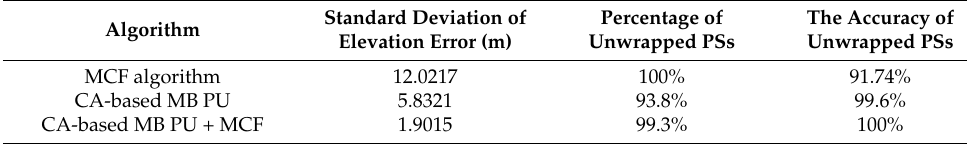
Table 1. Different algorithm processing results.